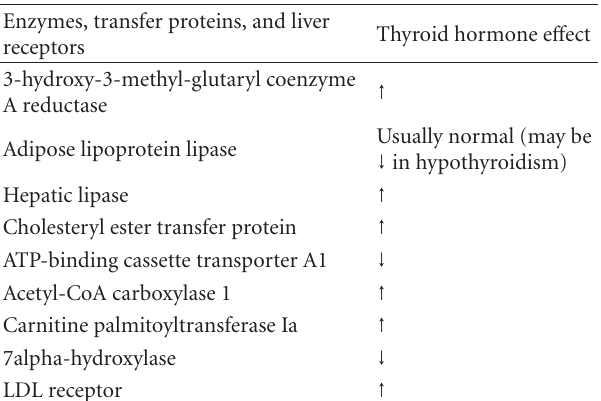
Table 1: Changes in enzyme activities, transfer proteins, and recep- tors involved in lipid metabolism induced by thyroid